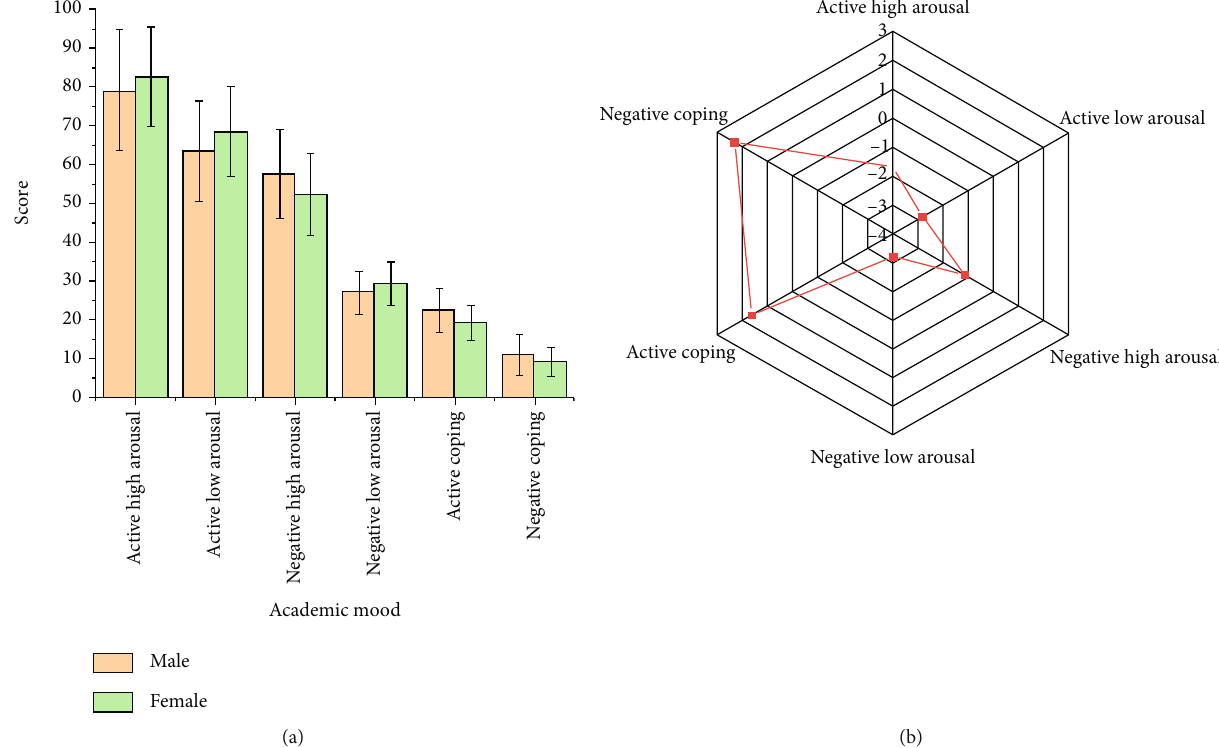
Figure 7: Di ff erences in academic emotions and coping styles among art students concerning genders ((a) score statistics for each dimension and (b) t -test results for each